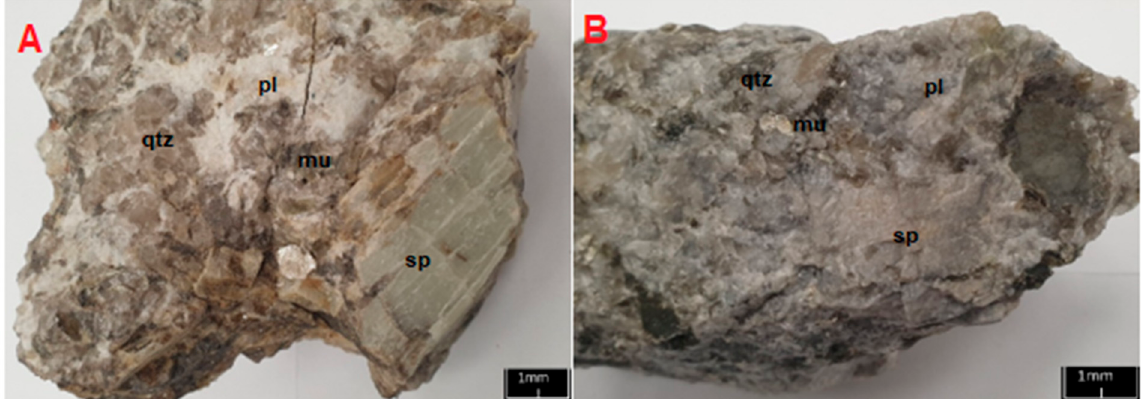
Figure 2. Macro photographs of the typical examples of LCT pegmatites from Kolmozero ( A ) and Kaustinen ( B ). Abbreviations: qtz—quartz, mu—muscovite, pl—plagioclase, sp—spodumene.